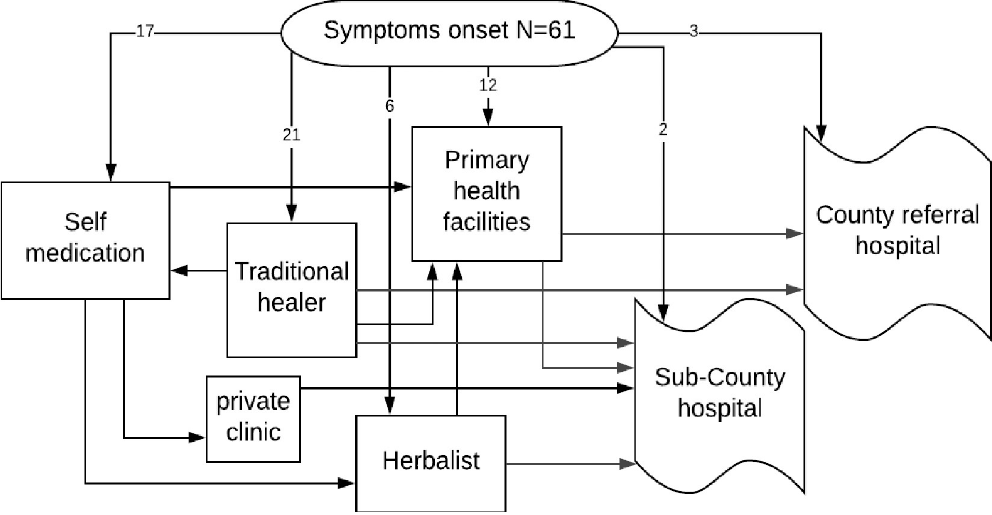
Fig 2. Schematic model of main treatment pathways followed by patients in West Pokot